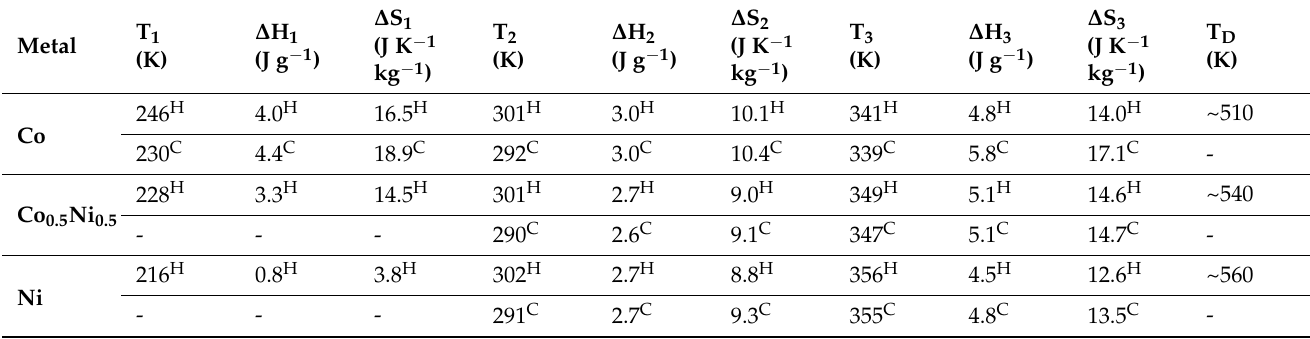
Table 1. Thermal parameters of [TPrA][Co 1 − x Ni x (dca) 3 ] (x = 0.0, 0.5 and 1.0). Note: H = on heating, C = on